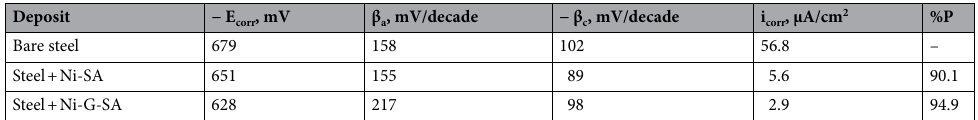
Table 4. The potentiodynamic polarization parameters for the bare steel and the superhydrophobic coated steel in 0.5 M NaCl solution.